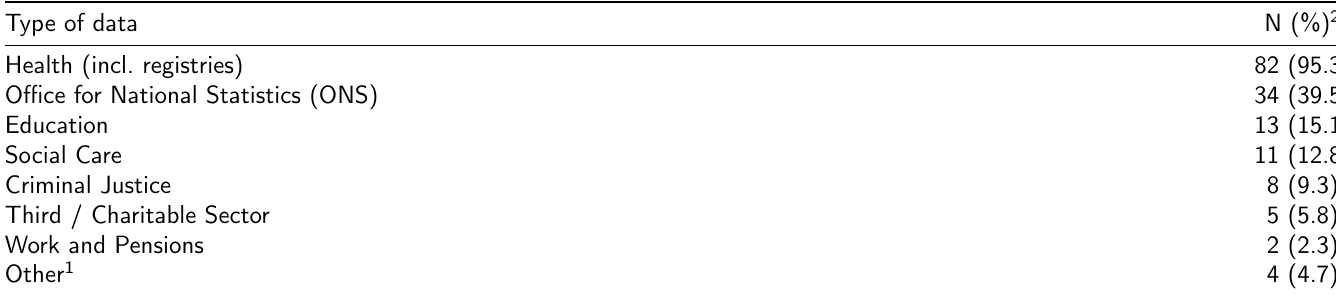
Table 2: Data types respondents reported